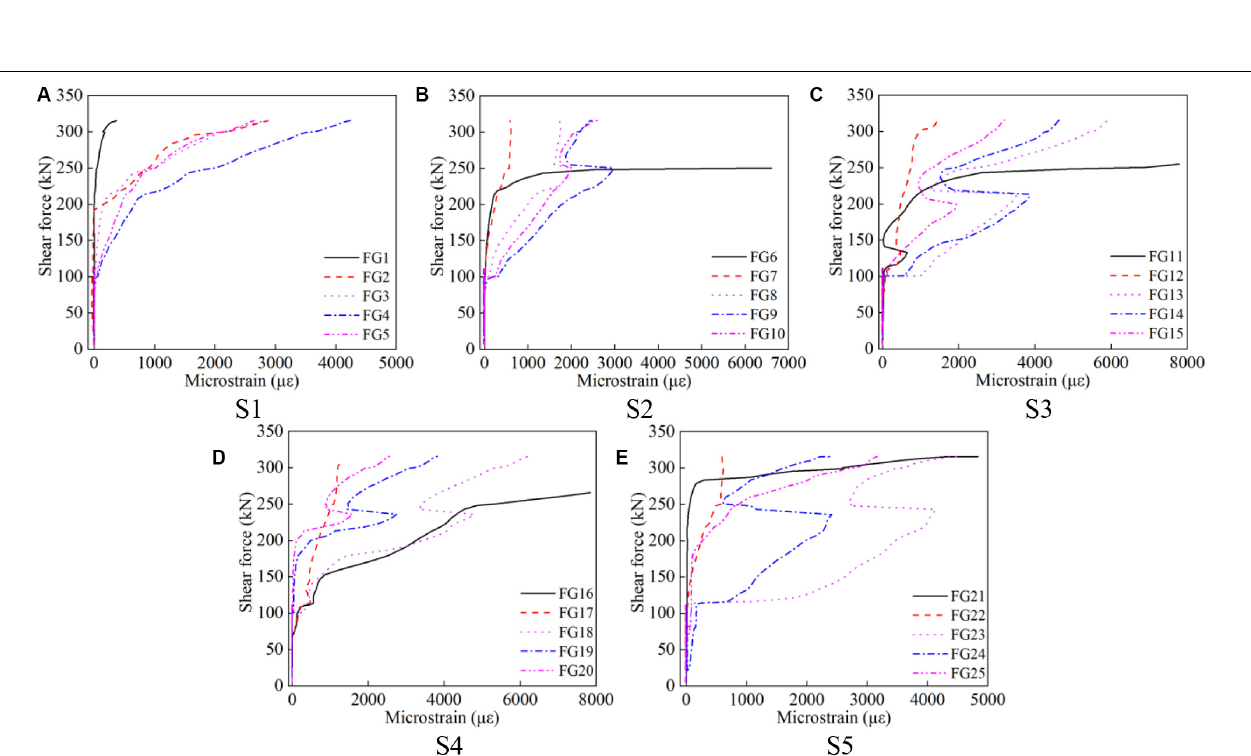
FIGURE 11 | Strain development in CFRP strips for EA-4-5. (A) S1, (B) S2, (C) S3, (D) S4, and (E) S5.